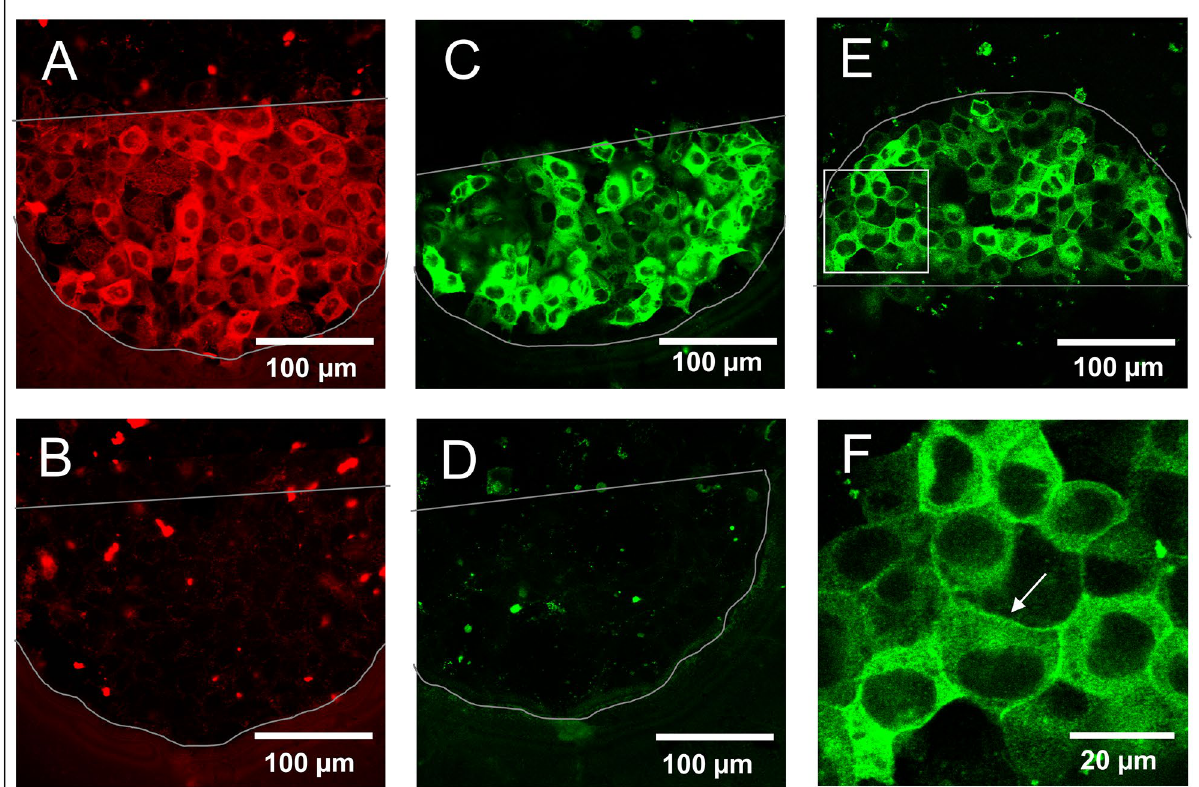
Figure 5. µISE-mediated loading of NRK cells with antibodies. Confocal fluorescence micrographs of NRK cells grown on half-circular electrodes (marked by grey outlines) after ( A ) electroporation in the presence of Alexa Fluor 546-labeled secondary antibody; ( B ) incubation with Alexa Fluor 546-labeled secondary antibody without electroporation; ( C ) electroporation in the presence of an anti-ß-catenin antibody followed by fixation, permeabilization and labelling of the bound anti ß-catenin antibody with an Alexa Fluor 488-labeled secondary antibody; ( D ) incubation with anti-ß-catenin antibody without electroporation followed by the